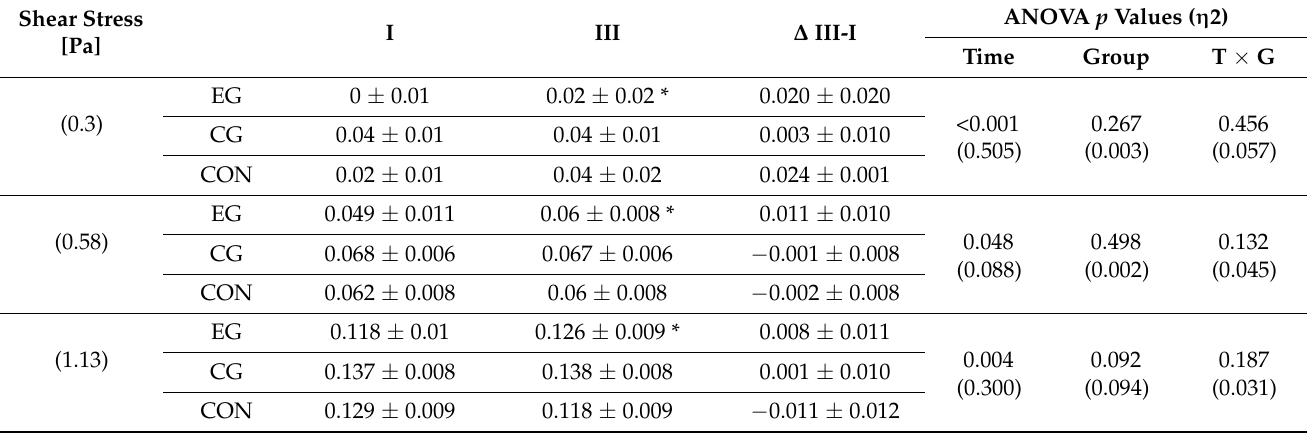
Table 7. Changes in elongation index (EI) at various levels of shear stress after 12-week training program in experimental (EG) and comparison group (CG) and at an interval of 3 months in control group